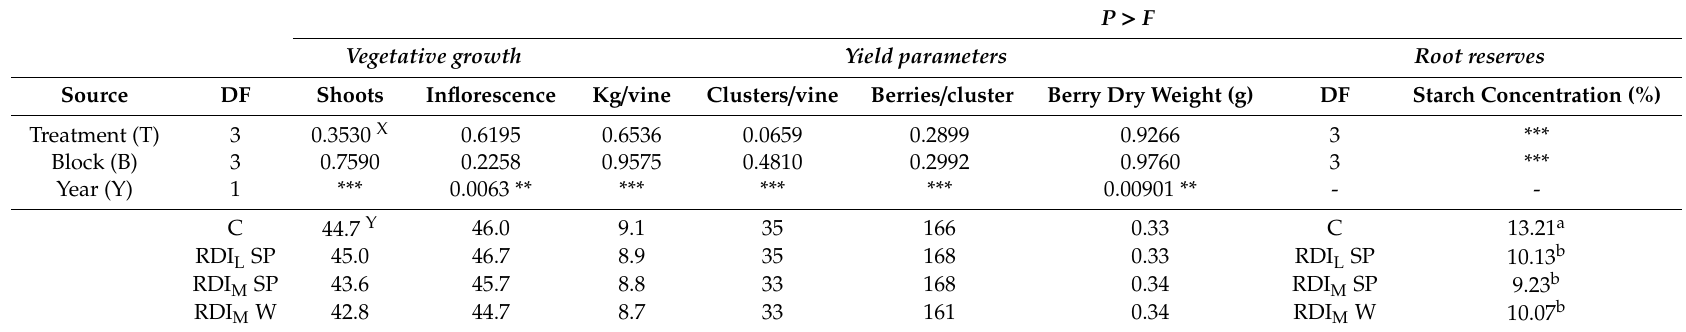
Table 2. Analysis of variance for the vegetative growth and yield parameters and their average estimates for the experimental period 2014–2016. The same analysis for measures of the starch concentration for the experimental year